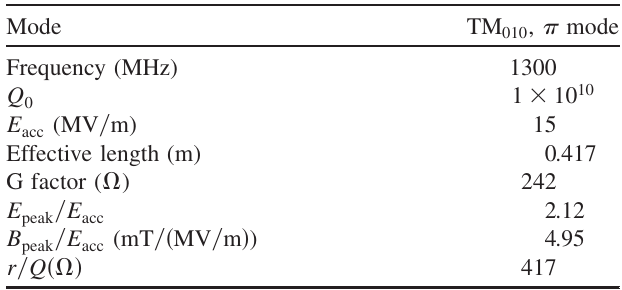
TABLE II. Design parameters of the 3.5-cell cavity.